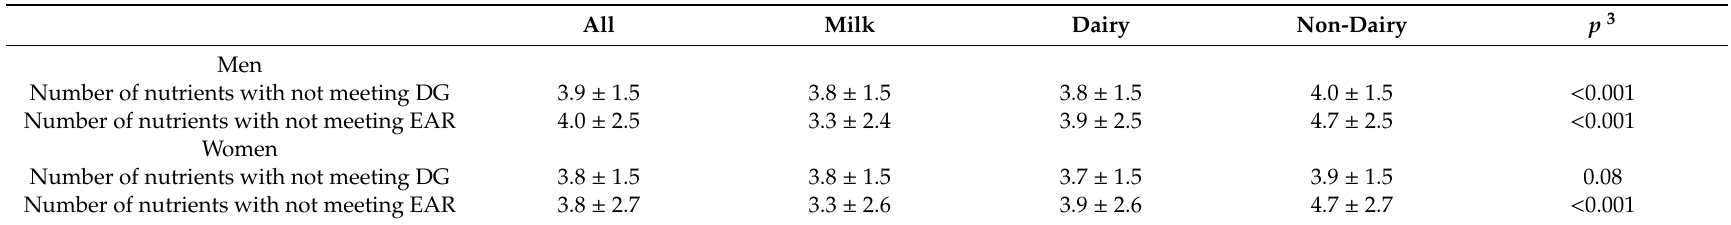
Table 6. Number of nutrients with not meeting DG and EAR among 9987 men and 11,619 women according to dairy intake status 1,2.